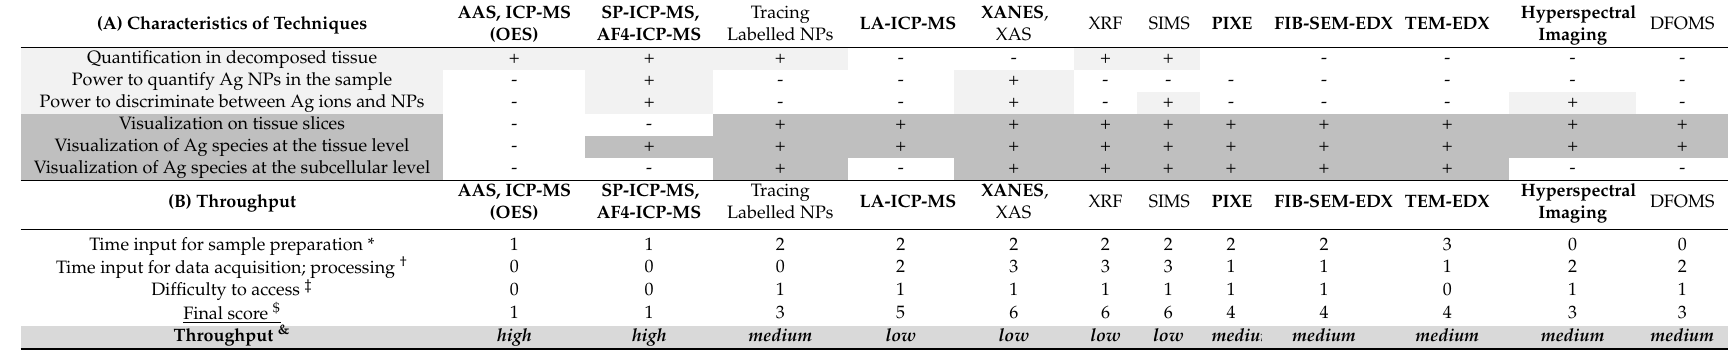
Table 1. The description of techniques used for in vivo investigations of NPs’ biological fate. We present the basic characteristics of the techniques (Table 1A) in terms of their quantification and visualization properties (+ means the method can do this, - means the method does not provide this information). The throughput of methods is evaluated based on the time input for sample preparation, time input for data acquisition and processing and the accessibility of the methods (Table 1B). (A) Characteristics of